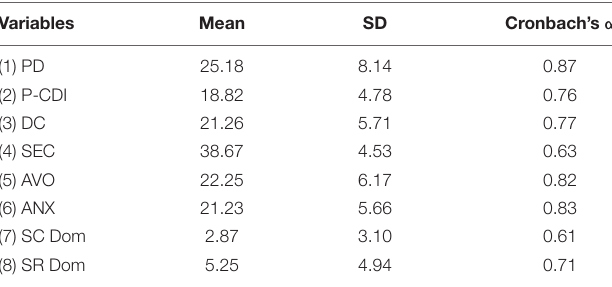
Variables Mean SD Cronbach’s